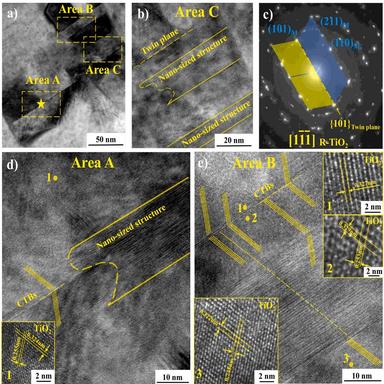
Microstructure of R-TiO2 with twinned structure: (a) TEM-BF image of R-TiO2, (b) HRTEM image of "Area C" marked in (a), (c) SAD patterns of the "yellow star" marker in (a), (d) HRTEM image of "Area A" marked in (a) with high magnification image inserted, (e) HRTEM image of "Area B" marked in (a) with high magnification images inserted. (For interpretation of the references to color in this figure legend, the reader is referred to the web version of this article.)